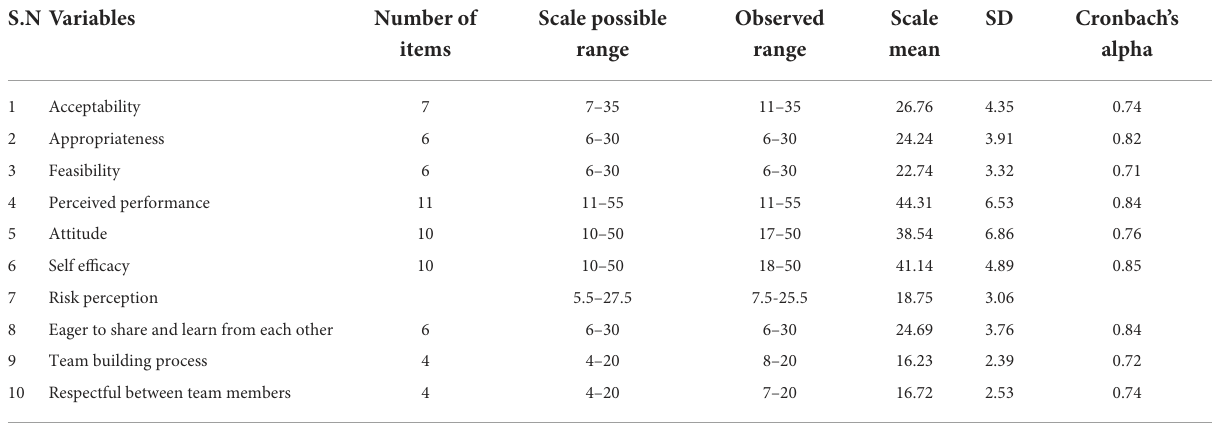
TABLE 5 Descriptive statistics for dependent and independent variables of trained peer educator’s student in Jimma